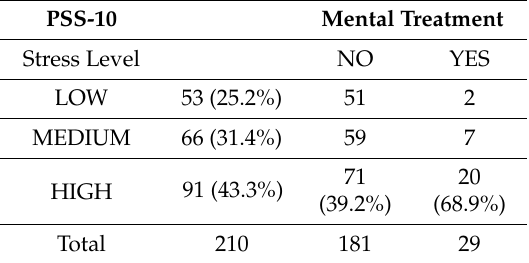
Table 3. The influence of mental treatment history on stress levels using PSS-10. p = 0.0062.